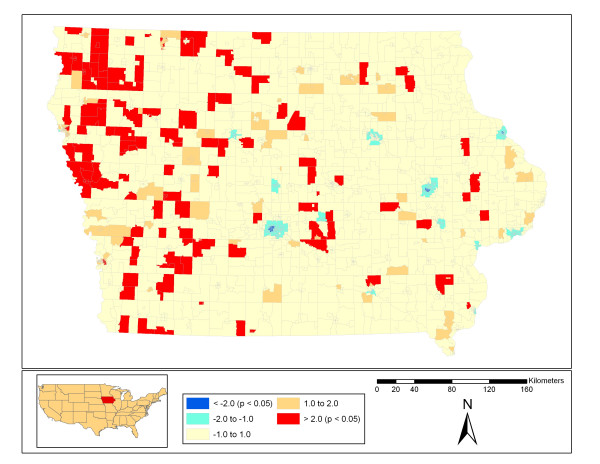
Hot-spot analysis result at five km distance threshold. Results of the hot-spot analysis (Getis-Ord Gi*) for human WNV disease rate from 2002–2006 by census block group with a 5 km threshold analysis distance. The values above 2.0 represent statistically significant hot-spots while below -2.0 are statistically significant cold-spots. The majority of census block groups fall in the statistically insignificant middle categories.